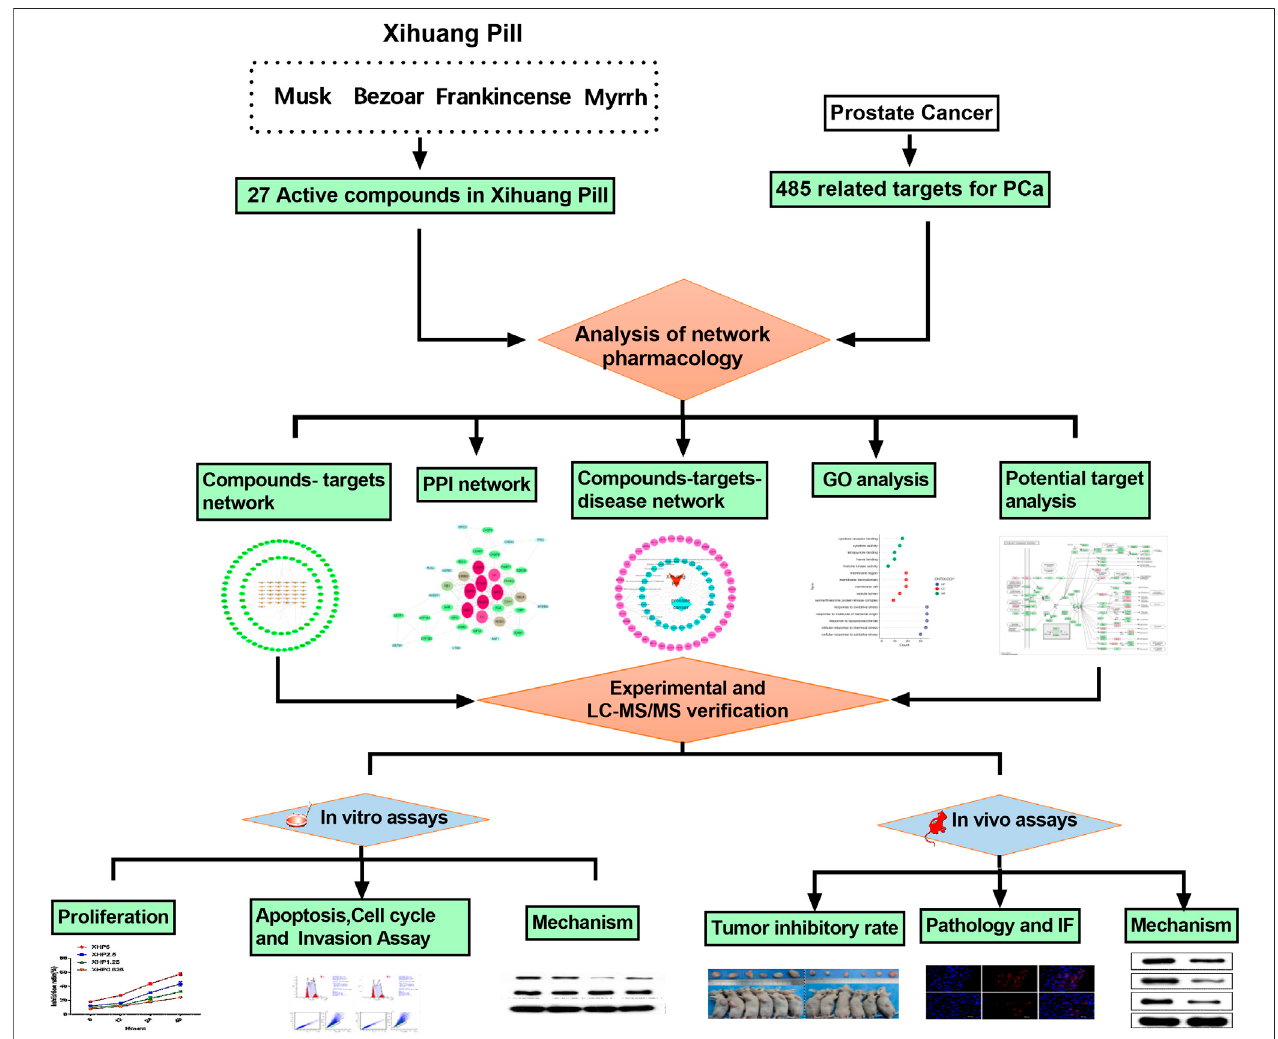
FIGURE 3 | The process of this research. This study was divided into three main sections:1) Prediction of the targets of XHP for prostate cancer by network pharmacology;2)Ultraperformance liquid chromatographycoupled withquadrupletime-of-ightmassspectrometry assayofXHP;3)Experimentalvalidationinvitroand in vivo to verify the mechanism of XHP in the treatment of prostate cancer was via PI3K/Akt/mTOR pathway.